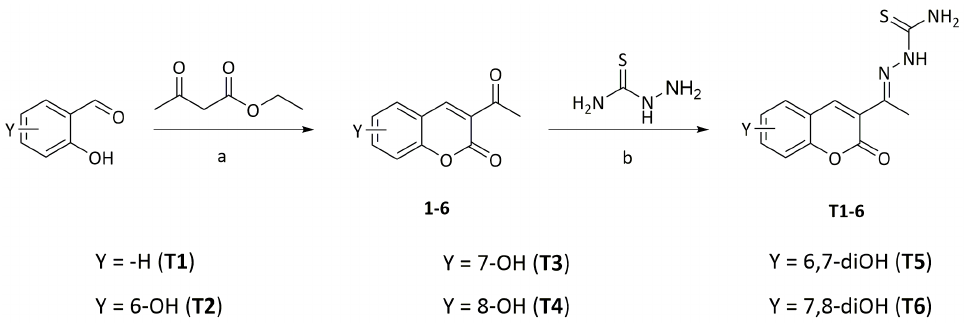
Scheme 1. Reaction scheme and structures of the synthesized compounds. Reaction conditions were: ( a ) piperidine; EtOH; reflux; 5 h. ( b ) Acetic acid; EtOH; reflux; 5 h.